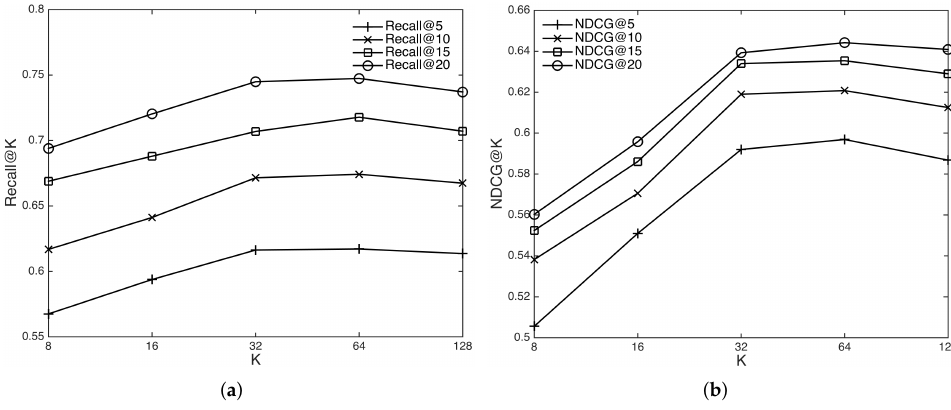
Figure 6. Impact of feature dimensions in GCN. ( a ) Recall@K; ( b )